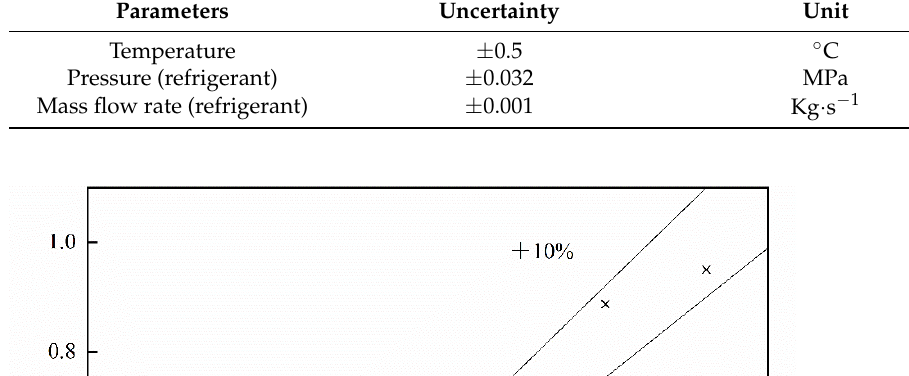
Figure 5. Structural sizes of ejector from the published literature [40]. Table 3. Measurement uncertainties of instrument from the published literature [40].